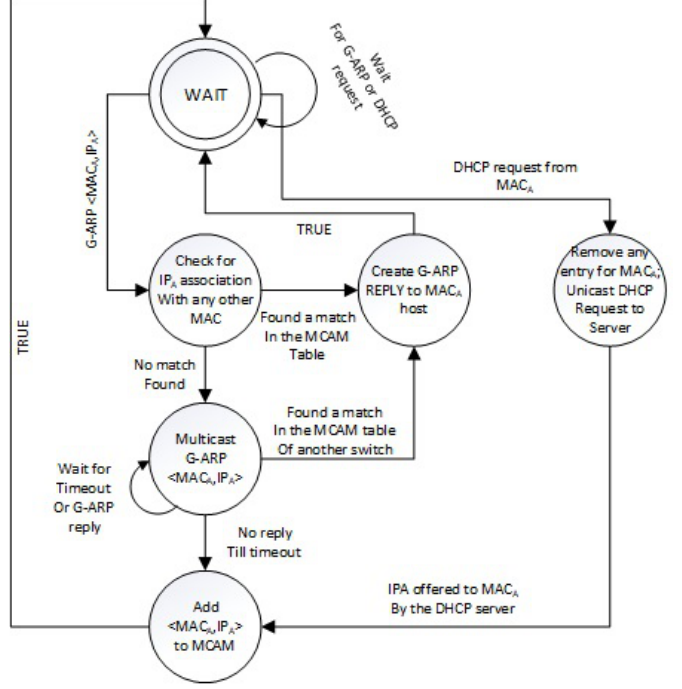
Figure 3. MCAM table build-up process. G-ARP, Gratuitous ARP; MCAM, Modified